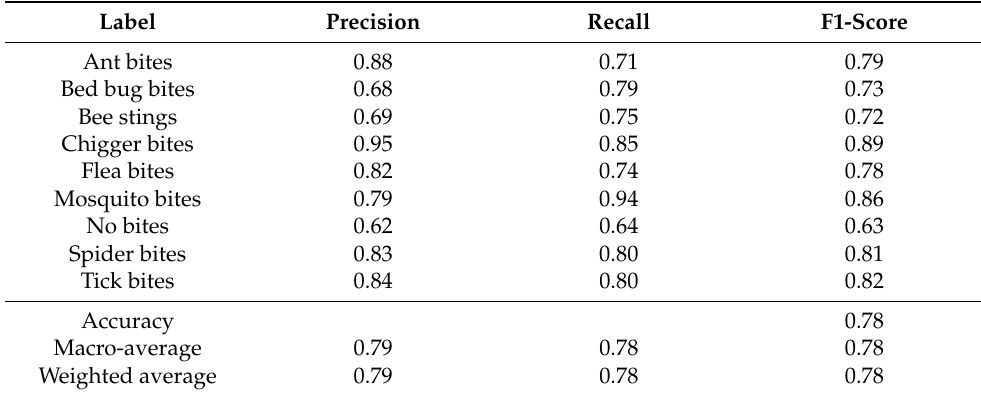
Table 13. Evaluation metrics for DenseNet169 model.